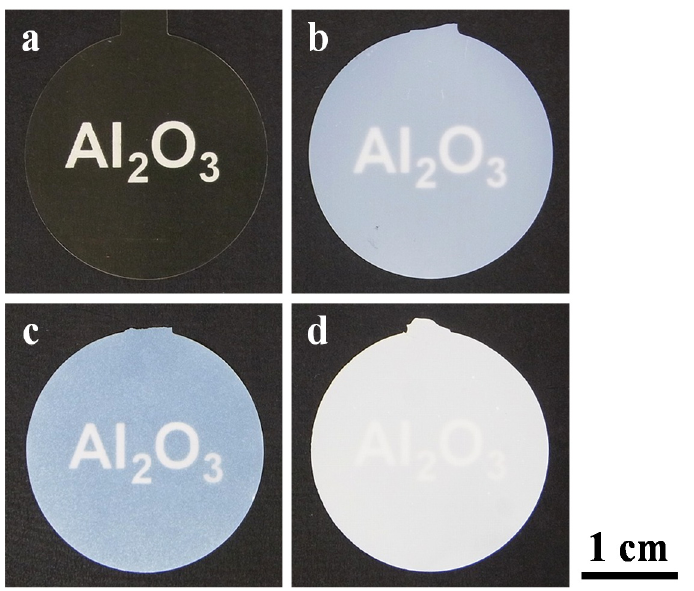
Figure 5. Photographs of ( a , b ) amorphous and ( c , d ) α -alumina membranes formed in ( a , c ) oxalic acid at 40 V and ( b , d ) phosphoric acid at 185 V. Through-hole treatment was conducted in phosphoric acid for ( a , c ) 5 min and ( b , d ) 120 min. Heat treatment was performed at ( c ) 1250 °C and ( d ) 1400 °C for 4 h. Alumina membranes were placed on a black background printed with the word “Al 2 O 3 ” in white, and the photographs were taken with a digital